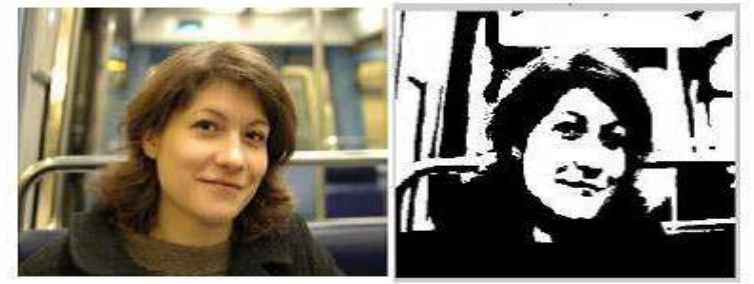
Figure 2. Face detection output